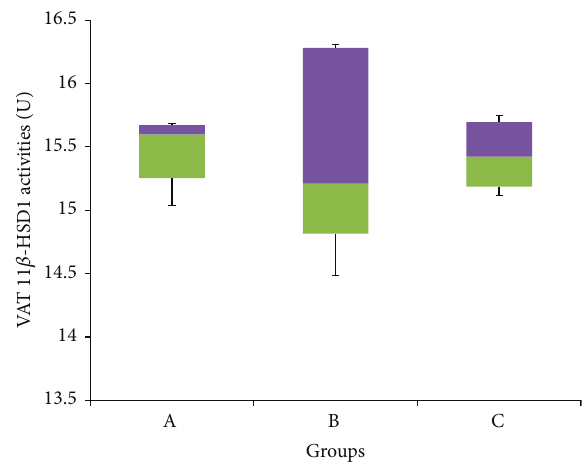
Figure 13: 11 𝛽 -HSD 1 activities in the visceral adipose tissue of rats in groups A, B, and C at the end of the four-week treatment period. Group A: control (HSD/HFD); group B: stress + HSD/HFD; group